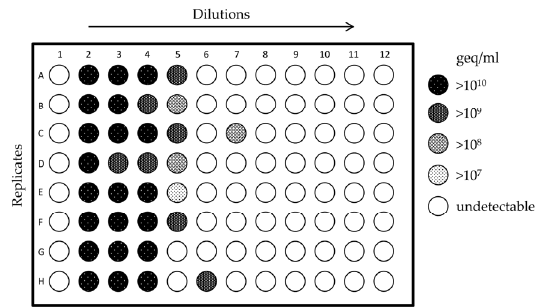
Figure 2. Determination of cutthroat trout virus (CTV) infectious titer by the Spearman–Kärber method. A 96 ‐ well plate used to determine the infectious titer of CTV is shown. Serial five ‐ fold dilutions in 8 ‐ plicates—starting from a 10 − 2 dilution of CTV cell culture supernatant (SN)—were used to infect RTGill ‐ W1 cells (seeded 4 × 10 4 cells per well). Rows 1 and 12 were left blank. The infectious titer of the stock virus SN (4 × 10 9 geq/mL) was 5.75 log (TCID 50 /mL).